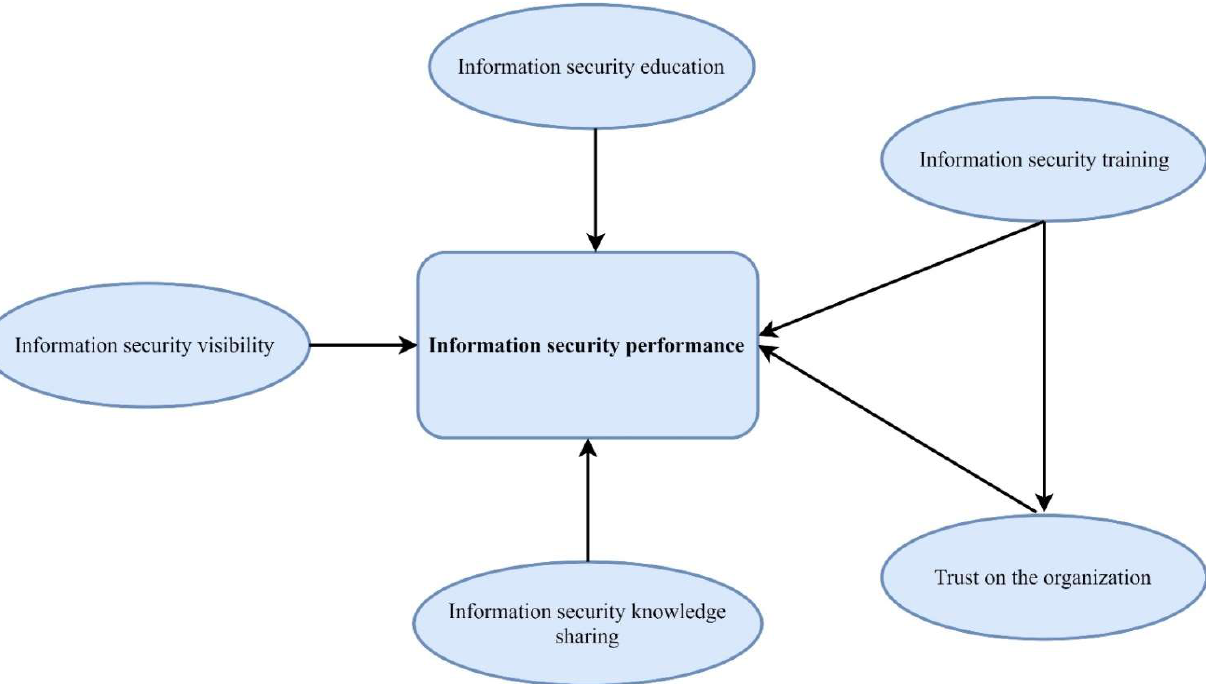
Figure 2. The conceptual framework.